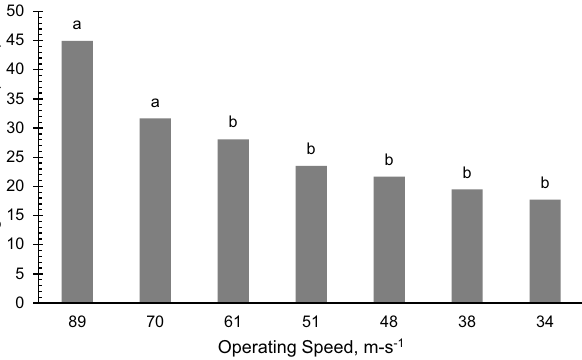
Figure 11. The influence of the different levels operating speeds (m s −1 ) on the Scattering Distance Ratio of deposited carrot seeds by the carrot seeder along the row. Operating speed with different letter denotes significant difference ( p < 0.005) on the